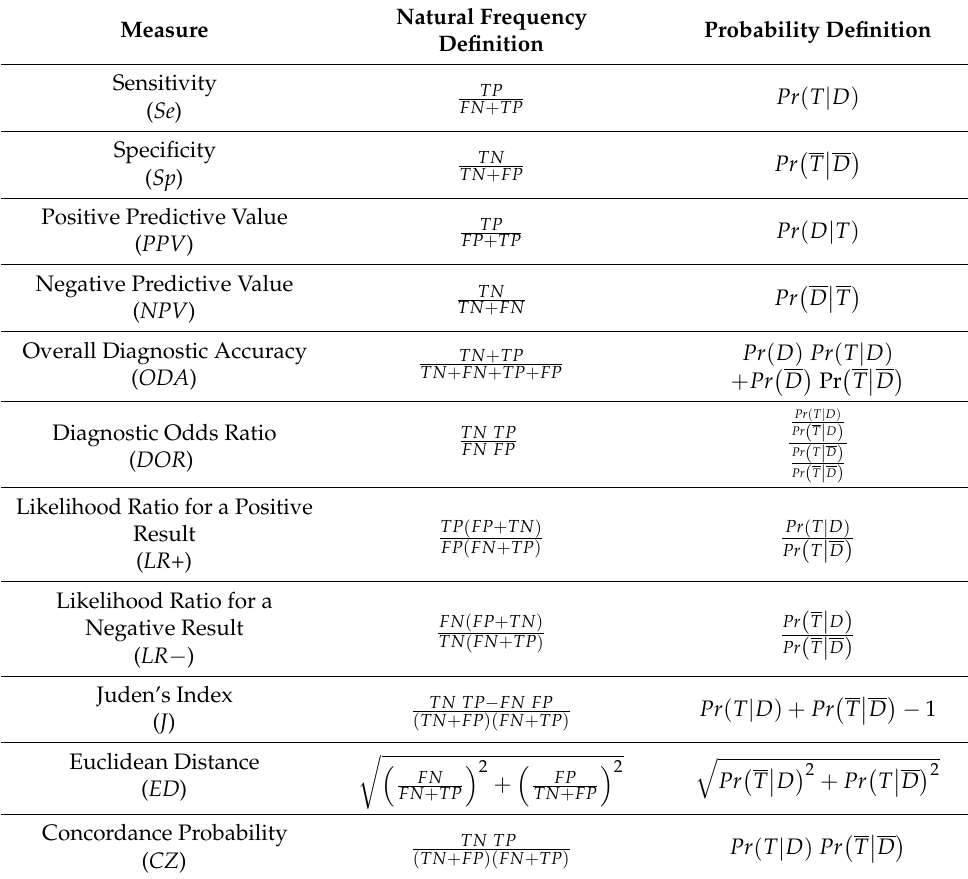
Table 2. Natural frequency and probability definitions of diagnostic accuracy